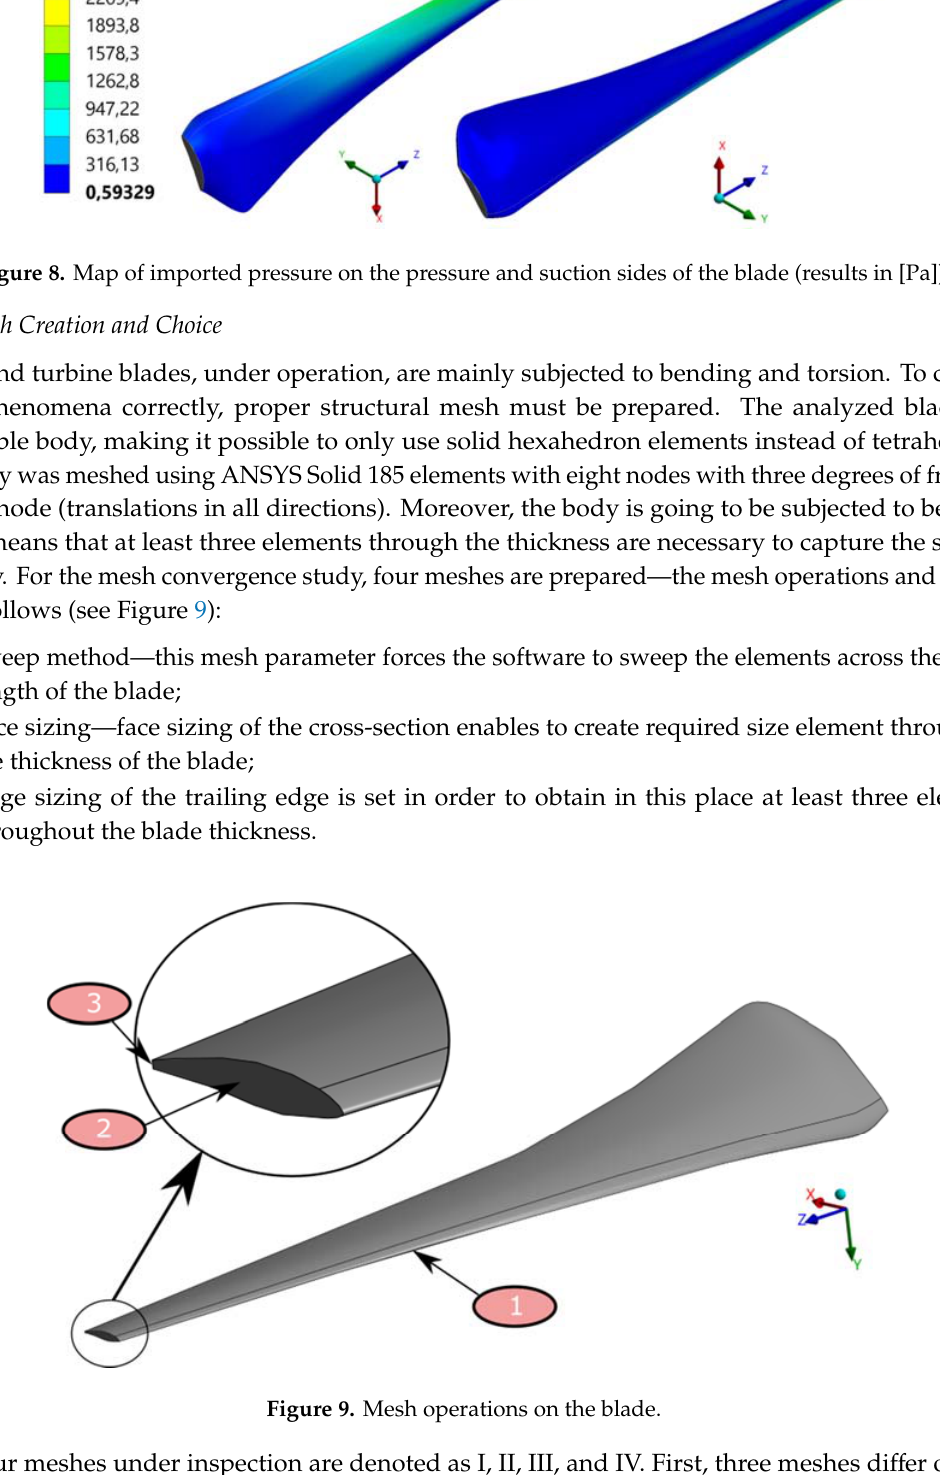
Figure 7. Applied loads and boundary conditions.